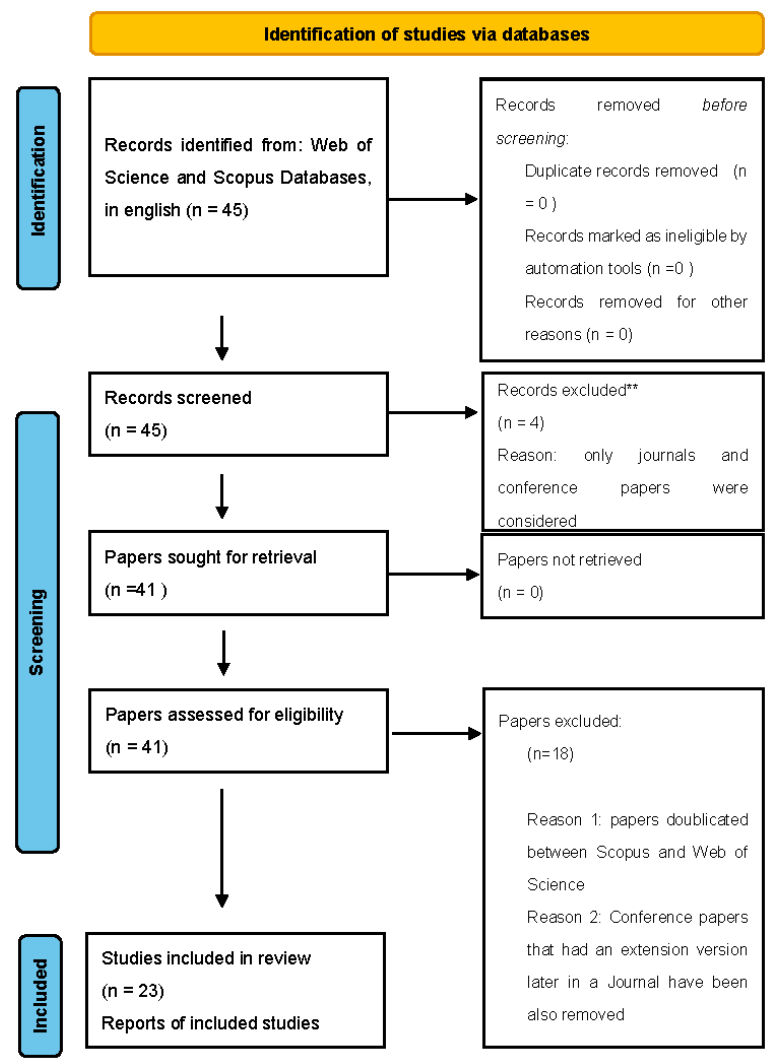
Figure 1. PRISMA 2020 flow diagram for systematic reviews.